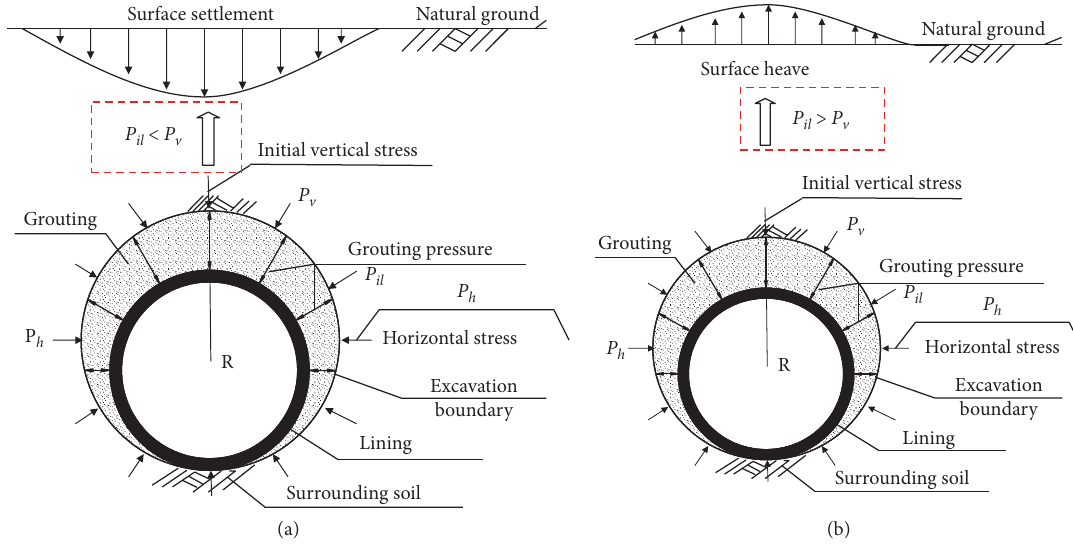
Figure 3: The surface movement during the shield tail grouting: (a) P